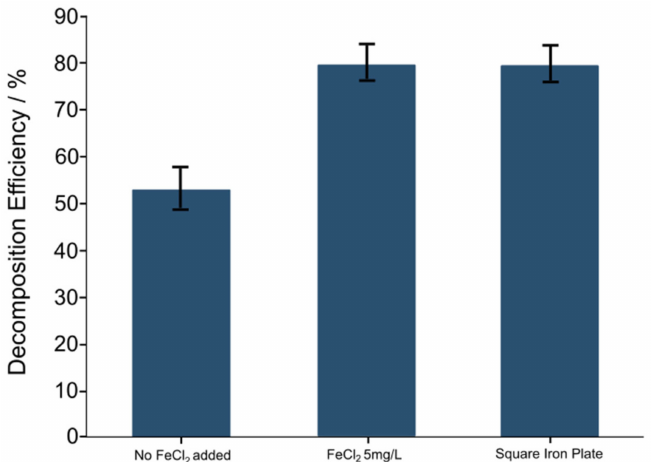
Figure 4. The RhB decomposition efficiency under different conditions at pH = 4.